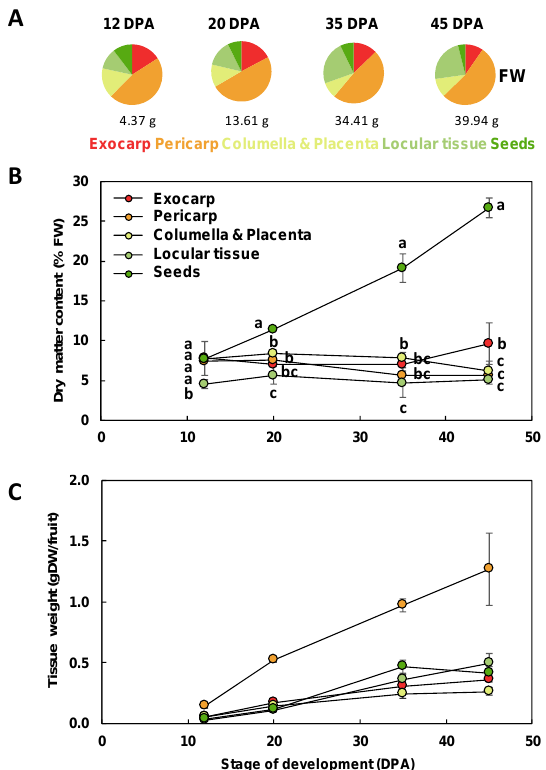
Figure 3. Tissue growth during Ailsa Craig tomato fruit development. ( A ) Tissue proportions along fruit development on a FW basis. The whole fruit mass is indicated below each plot. ( B ) Changes in dry matter content of the di ff erent fruit tissues. For each stage, means accompanied by the same letter were not significantly di ff erent (Tukey’s studentized test, P < 0.05). ( C ) Changes in the dry mass of each fruit tissue. Exocarp in red, Mesocarp with endocarp in orange, Columella with placenta in yellow, Locular tissue in light green, Seeds in dark green. Mean ± SD of 3 replicates per stage. Vertical bars represent SD.